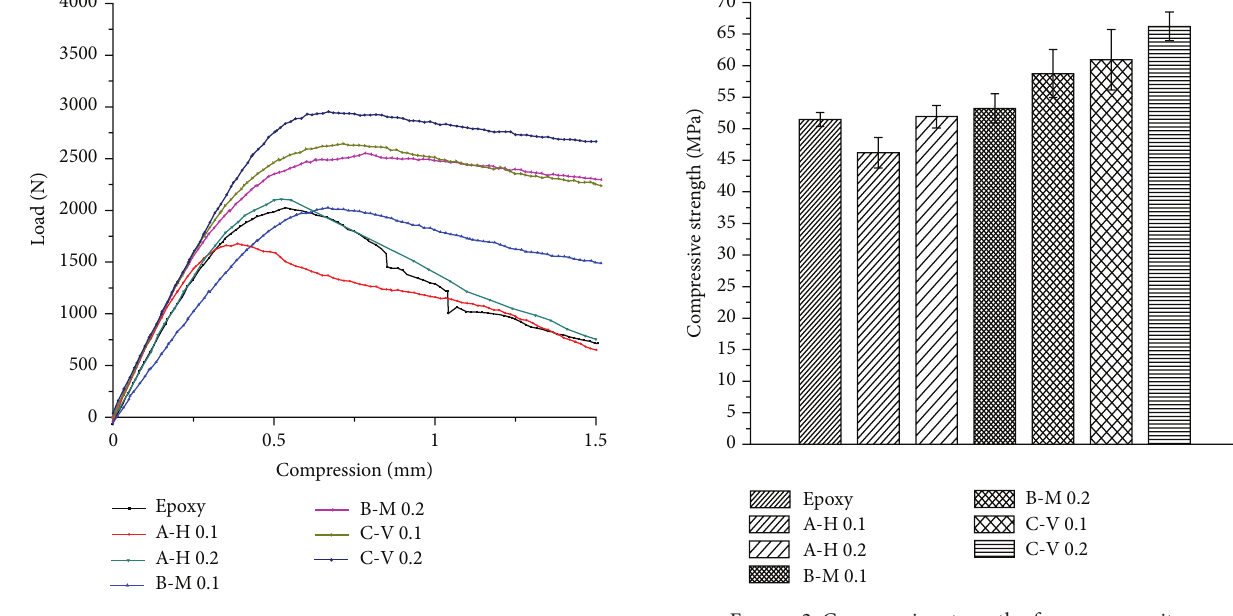
Figure 1: Load versus compression of epoxy nanocomposites. Figure 2: Compressive strength of nanocomposites.